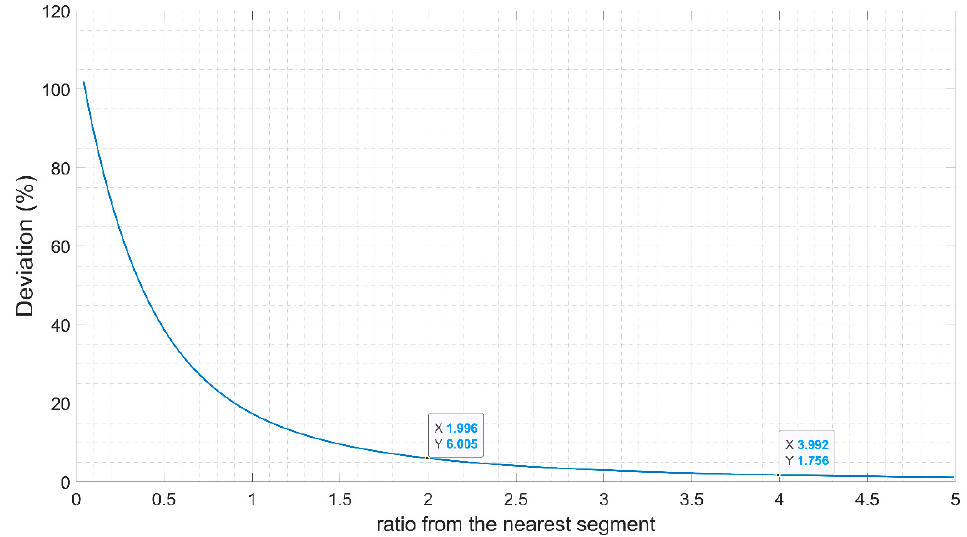
Figure 8. Deviation percentage between the two modeling approaches.